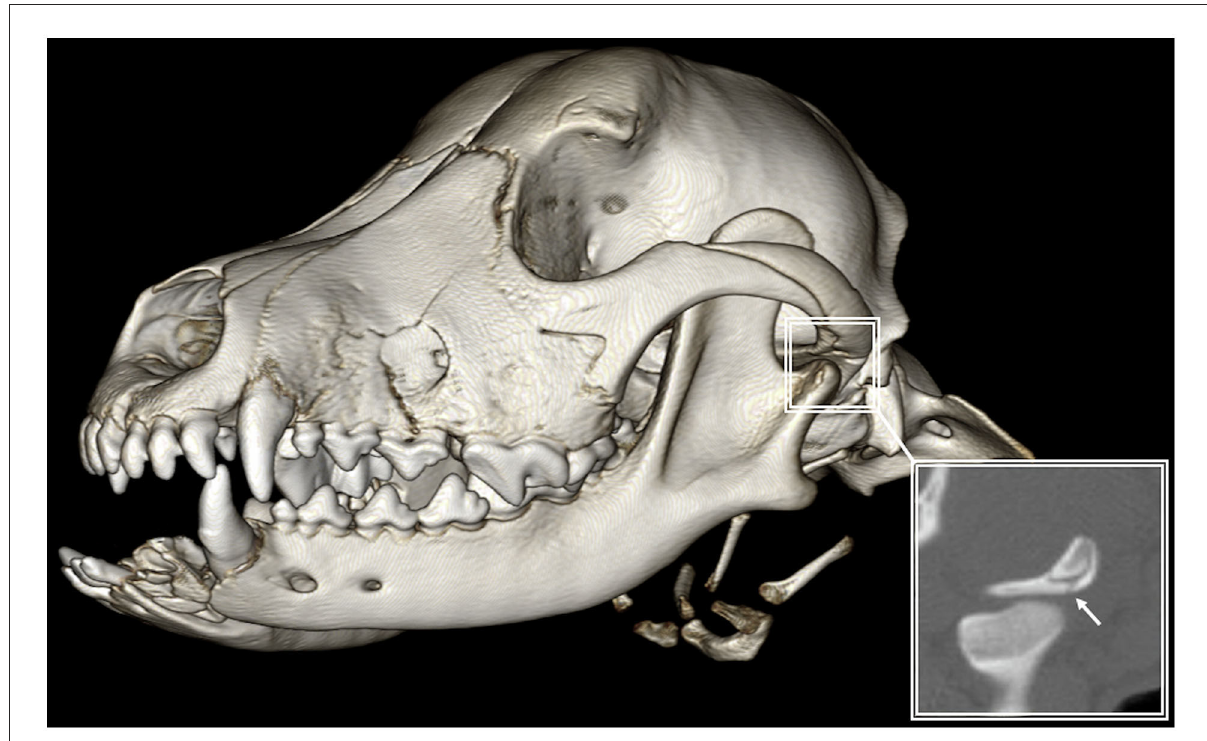
FIGURE11 3D-rendered CBCT image of the skull with reconstructed sagittal plane insert of a 6-month-old cross-breed dog. Rostral mandibular trauma was significantly associated with distant fractures of the articular surface (arrow) of the TMJ.